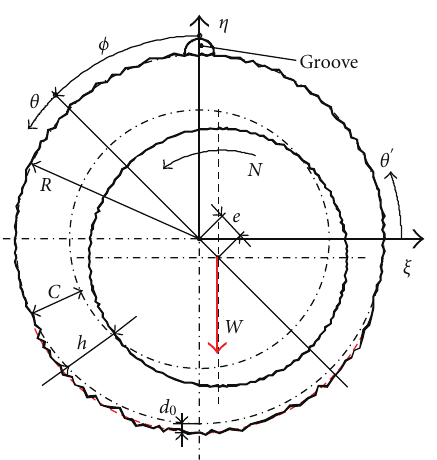
Figure 1: Schematic and coordinates of a plain hydrodynamic journal bearing with a wear dent.